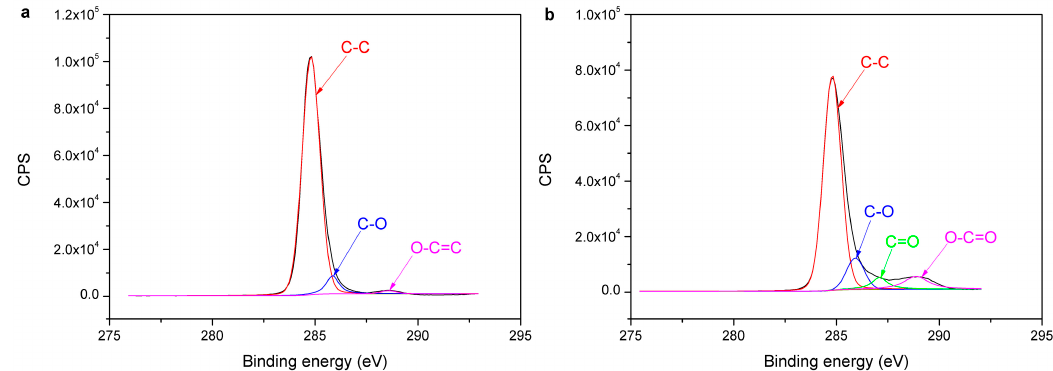
Figure 10. C1s spectra of polymer surface: ( a ) untreated PE; ( b ) treated PE.